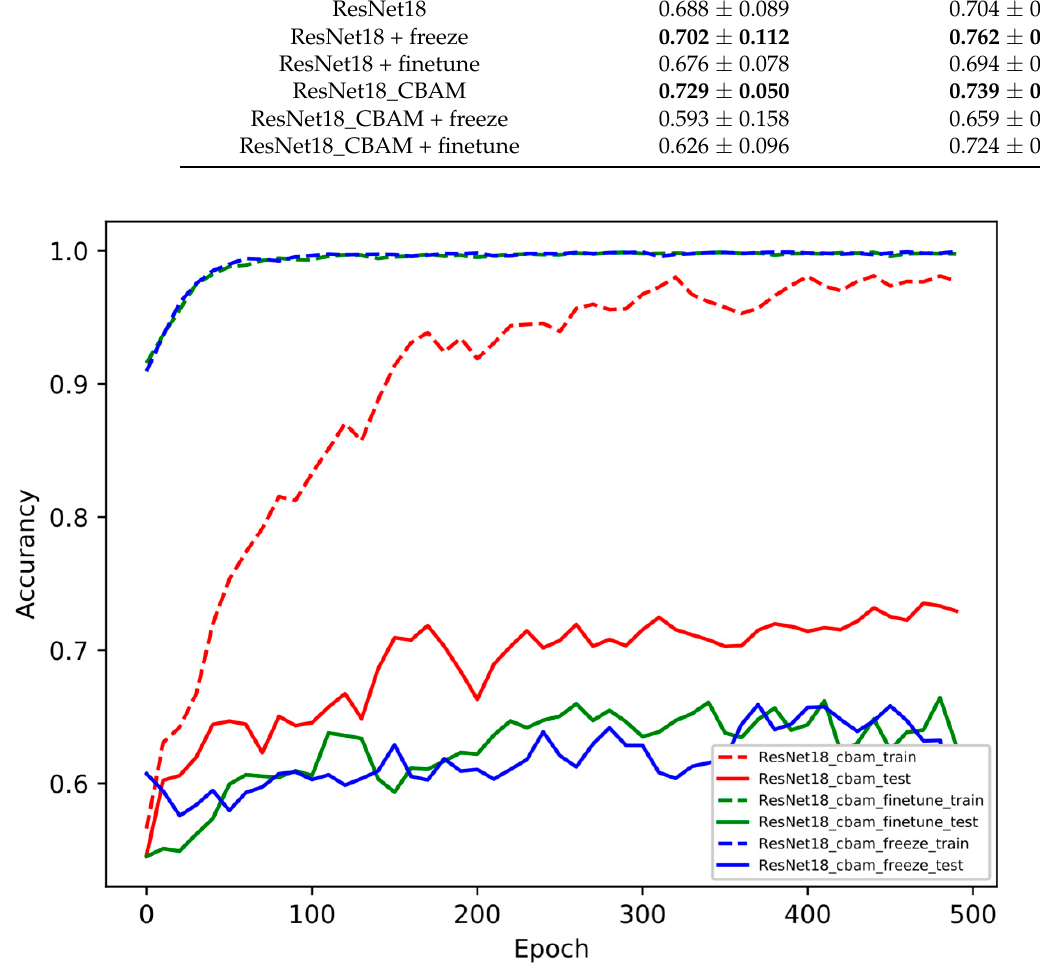
Figure 4. Training curves of transfer learning models. The curves were obtained by the same way as Figure 3.